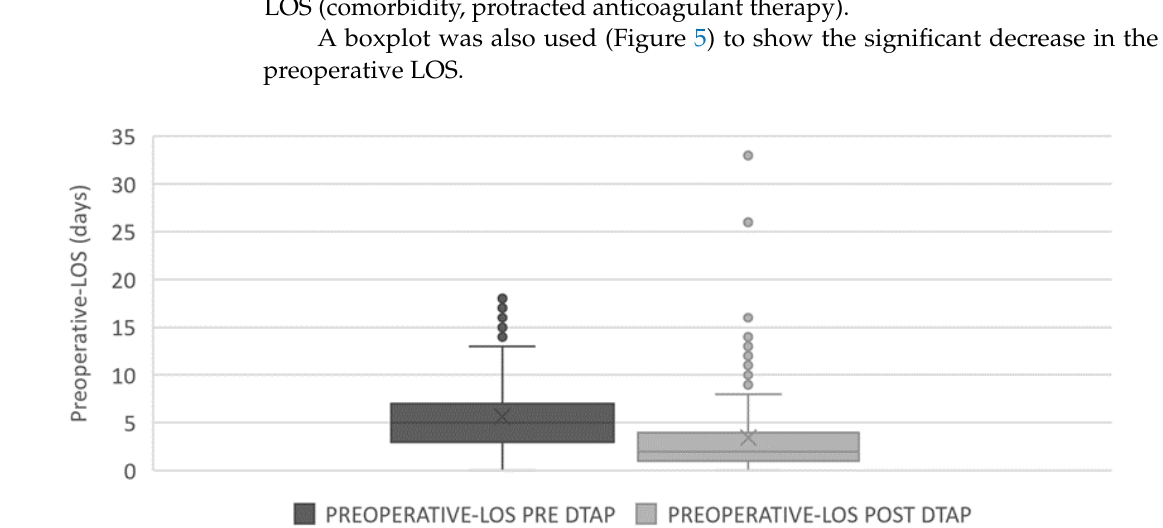
Figure 5. Boxplot of preoperative LOS before and after DTAP.